Question: Condense the content of this figure into a single sentence.
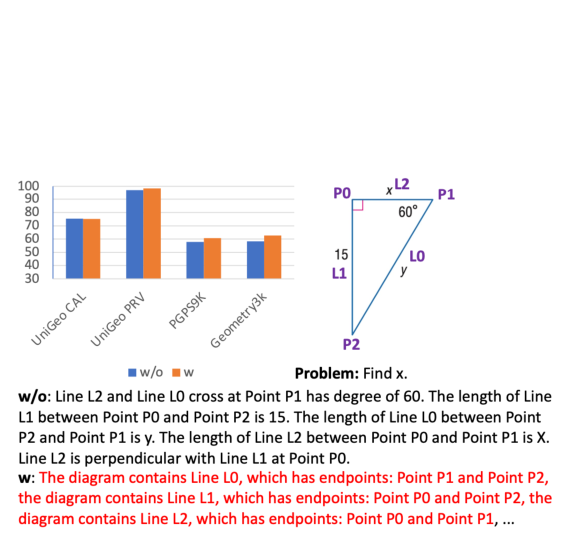
Answer: Top-left: the performance of the GOLD (using T5-base) with (w) and without (w/o) the geo2geo. Top- right: Geometry math problem. Bottom: Predicted diagram description with and without the geo2geo. The same text between (w) and (w/o) is omitted for space consideration, where the red text is geo2geo relations.